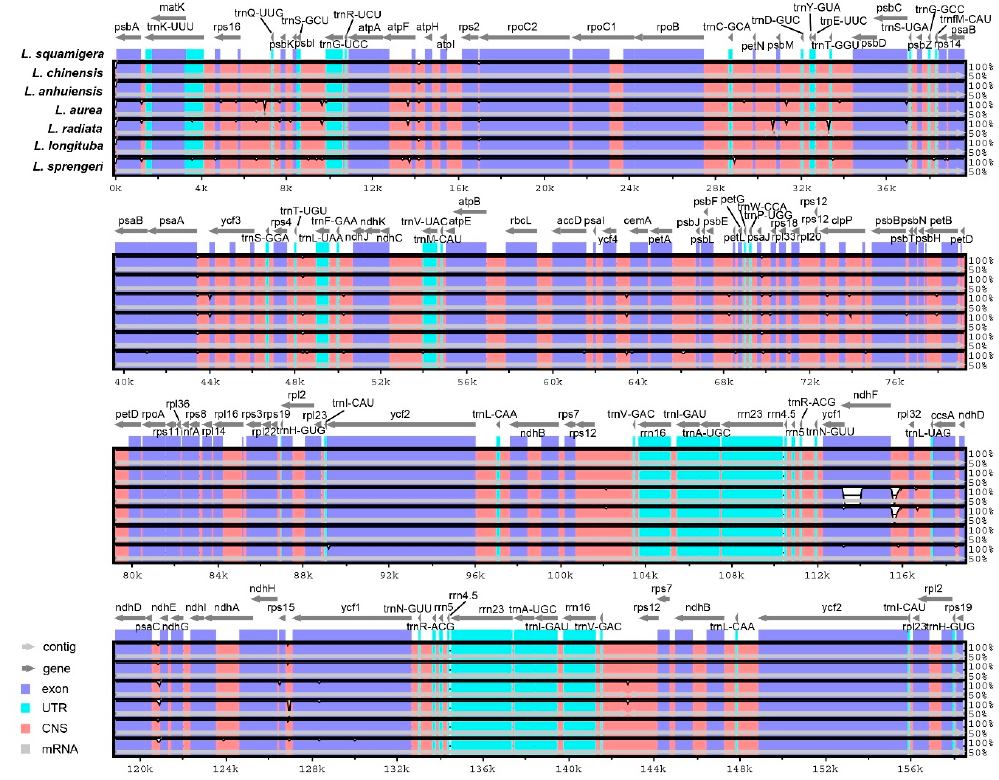
Figure 4. mVISTA identity plot based on the complete cp sequence alignment by Shuffle-LAGAN for seven Lycoris species. L. squamigera was selected as a reference. The pink regions are Conserved Non-Coding Sequences (CNS), the dark blue regions are exons, and the light-blue regions are UTRs. Arrows signifying genes are drawn above the graphs, pointing in the direction of the gene. 70% cut-off identity was used for the plots, and the Y-scale represents the percent identity from 50% to 100%.